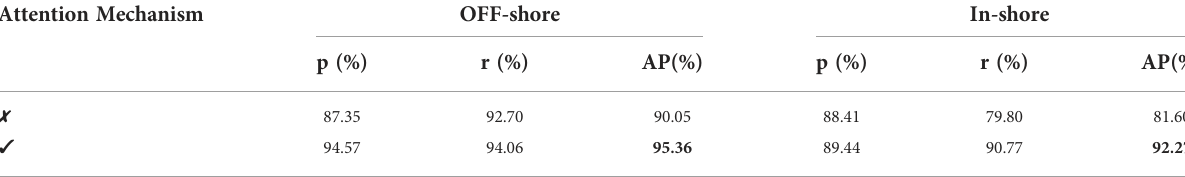
TABLE 8 The ablation study of our proposed model removal and installation the attention mechanism module on the SSDD dataset. Attention